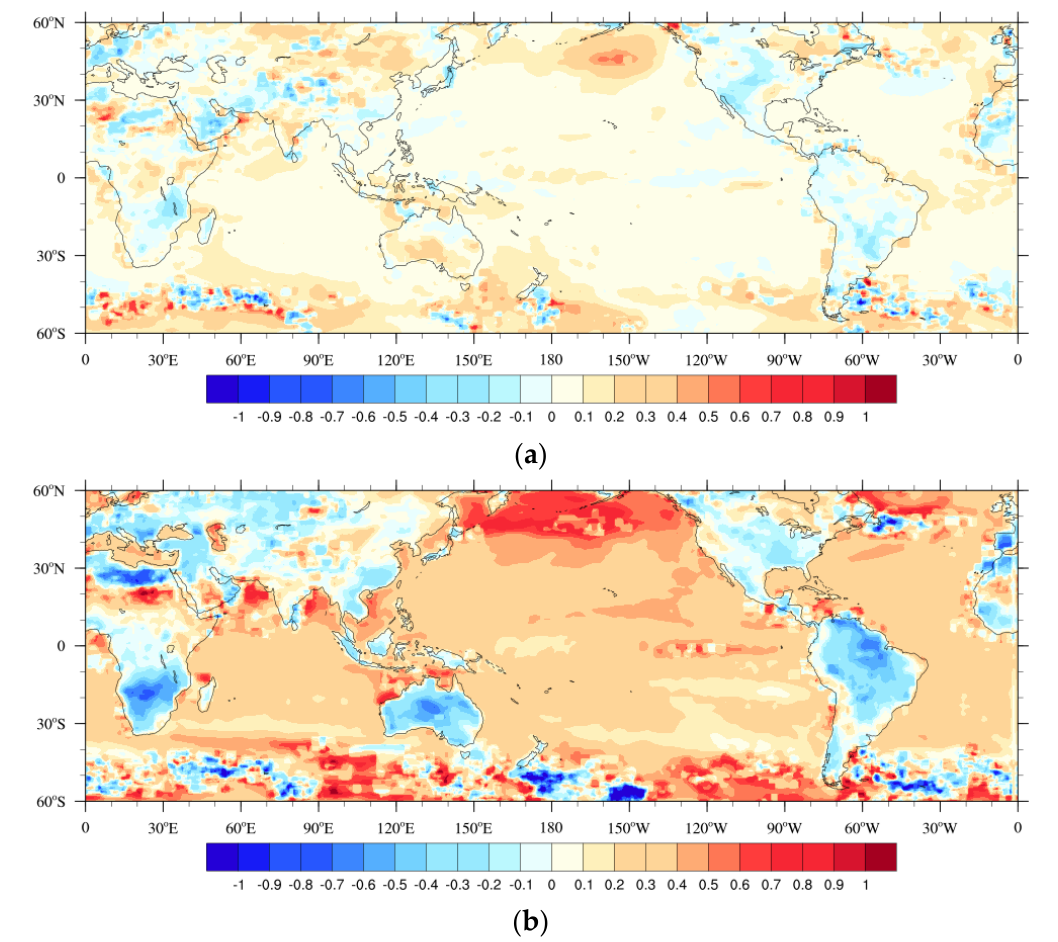
Figure 6. Spatial distribution of multi-model mean relative efficiency anomaly across the CMIP5 simulations. (a) Difference in LE/H between 1860 and 2005 normalized by the mean LE/H value of 1850–1860 in the historical Scenario. ( b ) Difference in LE/H between 2006 and 2100 normalized by the mean LE/H value of 1995–2005 in the RCP8.5 scenario.